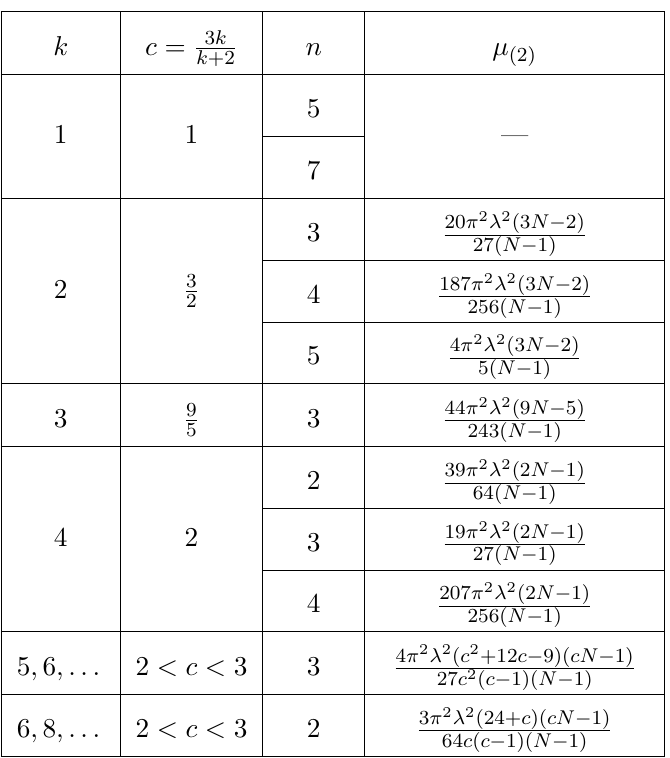
Table 3 . The anomalous dimensions of the spin-2 current W 2 of the symmetric orbifolds of the N = 2 minimal models. When c = 1 , the W 2 current becomes null and the anomalous dimension of the unnormalized current vanishes. Note that for n = 3 , the anomalous dimension is strictly greater than zero for all 3 ≤ c < 3 2